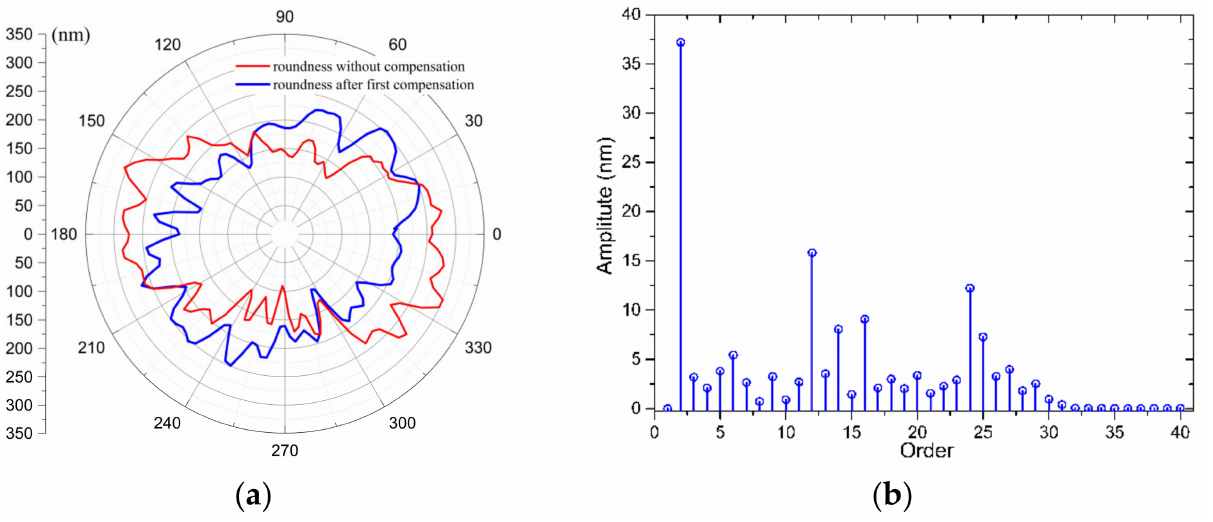
Figure 16. The WRE of the mandrel and its spectrum after the first compensation: ( a ) WRE graph in a polar coordinate system, ( b ) Error